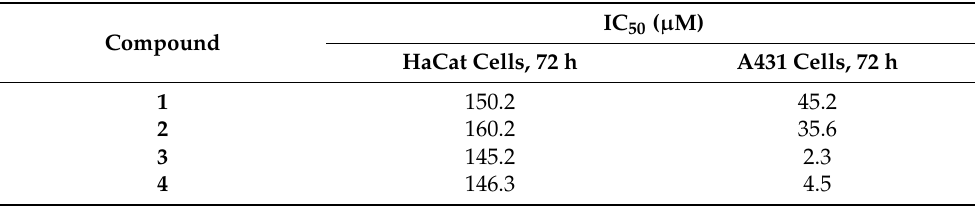
Table 8. IC 50 evaluated after 72 h incubation in A431 cancer cell lines and human keratinocytes as the control. ( 1 ) Betulin; ( 2 ) betulinic acid; ( 3 ) betulin-lysine; ( 4 ) betulin-ornithine.